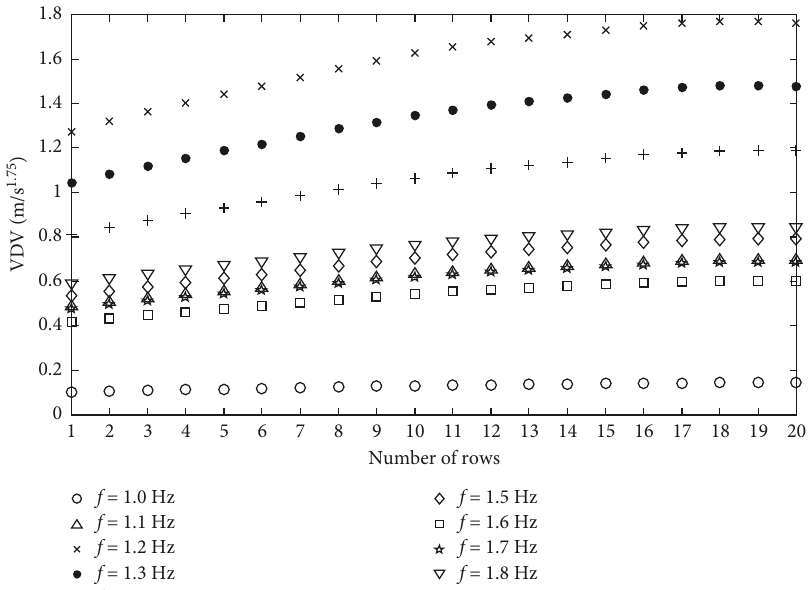
Figure 21: The VDVs of each row of